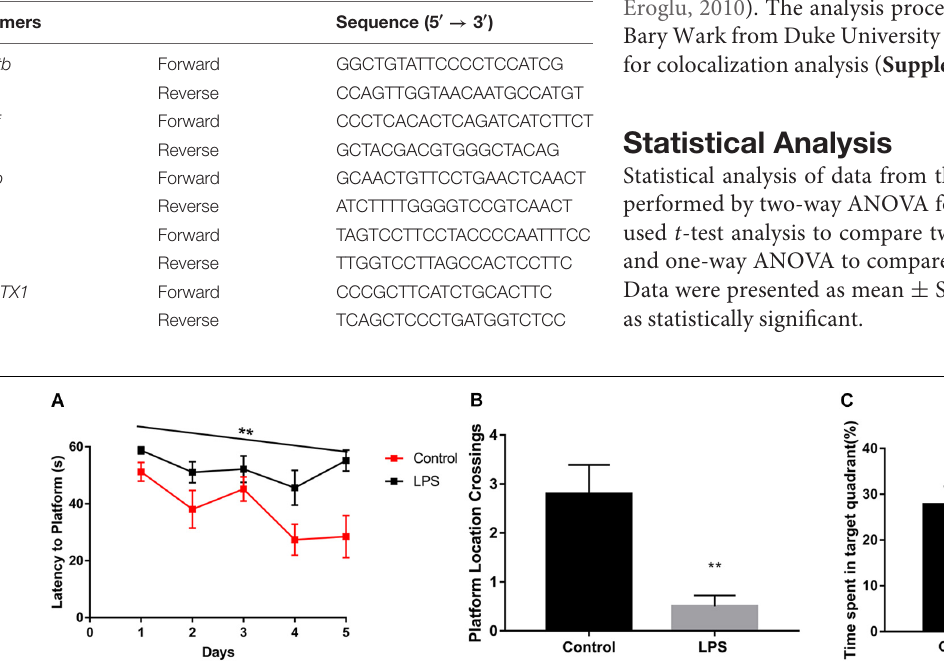
FIGURE 1 | Effects of LPS on memory acquisition and retention performance in the Morris water maze behavioral task. After 7 days of LPS administration, the control and LPS-injected mice were subjected to the Morris water maze spatial learning task for 5 days. (A) Latency before finding the target platform was recorded daily (mean of 4 trials per day, ∗∗ P < 0.01 by repeated measures two-way ANOVA, n = 10). (B,C) After 5 trial days, the control and LPS-injected mice were tested and assessed based on the number of times they crossed the platform location (B) and the time spent in the target quadrant(C). ∗ P < 0.05, ∗∗ P < 0.01 vs. control by unpaired two-tailed t -test, n =